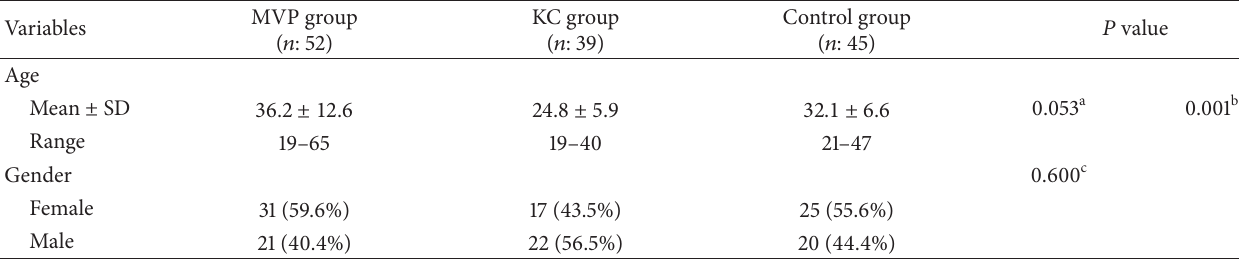
Table 1: Demographic characteristics of the patients and the control Group.